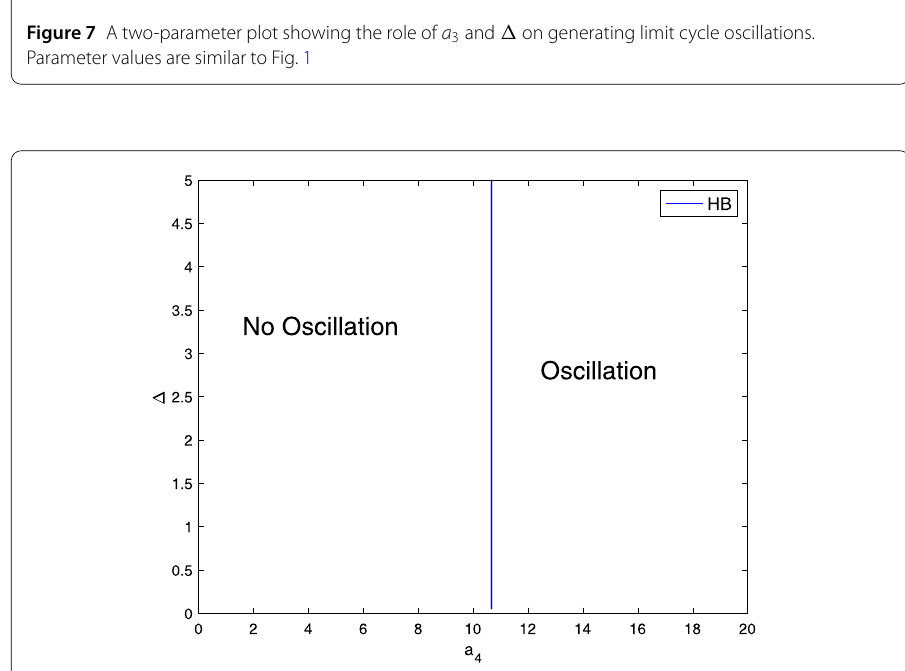
Figure 8 A two-parameter plot showing the role of a 4 and (cid:5) on generating limit cycle oscillations. Parameter values are similar to those in Fig. 1